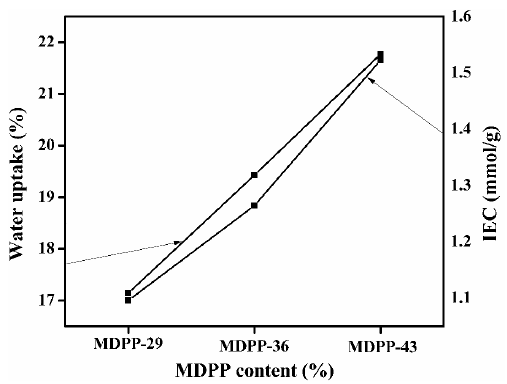
Figure 5. Ion exchange capacity and water uptake of membranes MDPP-29 to MDPP-43.